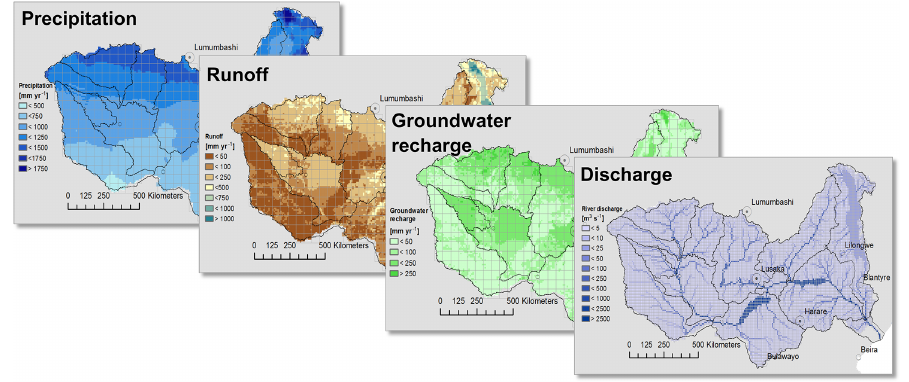
Figure 11. Parameter sets of different hydrological variables.